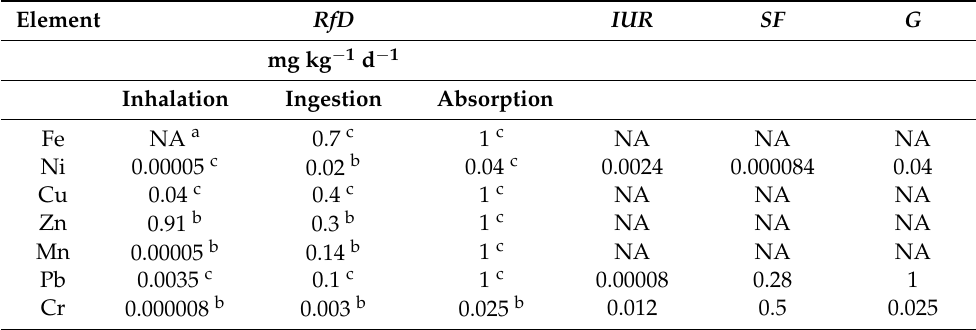
Table 4. Parameters used for risk assessment and indoor PM 10 elemental